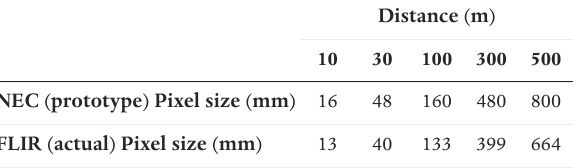
Table 2. Pixel size of NEC and FLIR cameras vs viewing